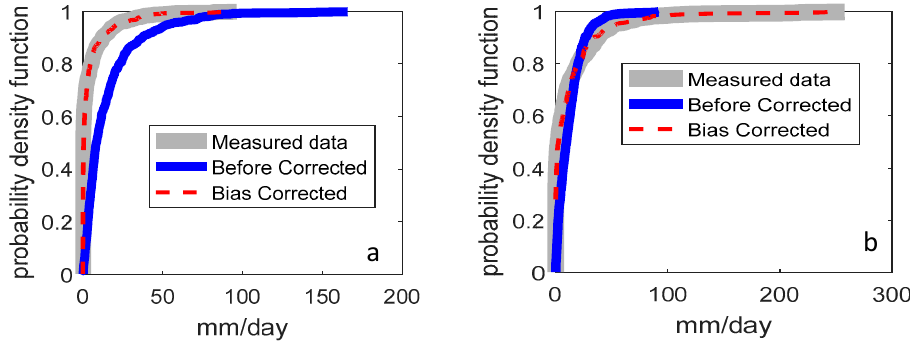
Figure 4. Before and after corrected precipitation in comparison with measured data for Tramy station in January ( a ) and August ( b ).